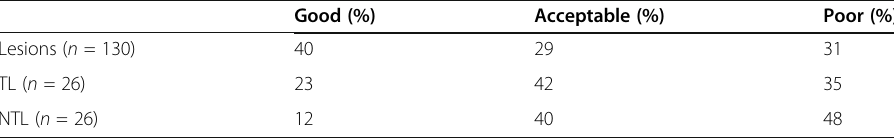
Table 3 Concordance rates between D Post-treatment-R and D Predicitve-D for all VOIs, based on their QF